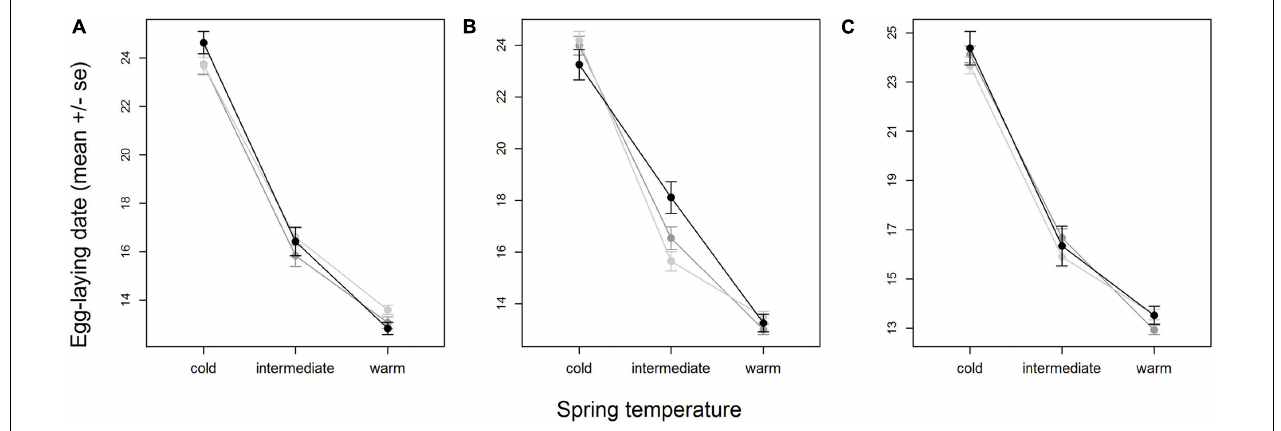
FIGURE 3 | Variation in egg-laying dates of SNP genotypes with temperature for the three SNPs with the most significant interaction with temperature ( Table 2 ), AX-100216683 (A) , AX-100724221 (B) and AX-100140360 (C) . Shown are means and standard errors, indicated by whiskers, for homozygote 1 (light gray), heterozygote (medium gray) and homozygote 2 (black). Plotting the area- and year-centered egg-laying dates that were used in the analysis would give a horizontal mean reaction norm. To show the real differences in egg-laying dates with temperature, we here plotted ‘raw’ egg-laying dates that were not corrected for year- and area effects. Note that therefore part of the variation within SNP- and temperature-classes is due to variation among areas. Sample sizes per temperature class-genotype group ranged between 77 and 757 individuals and were on average 381.2.